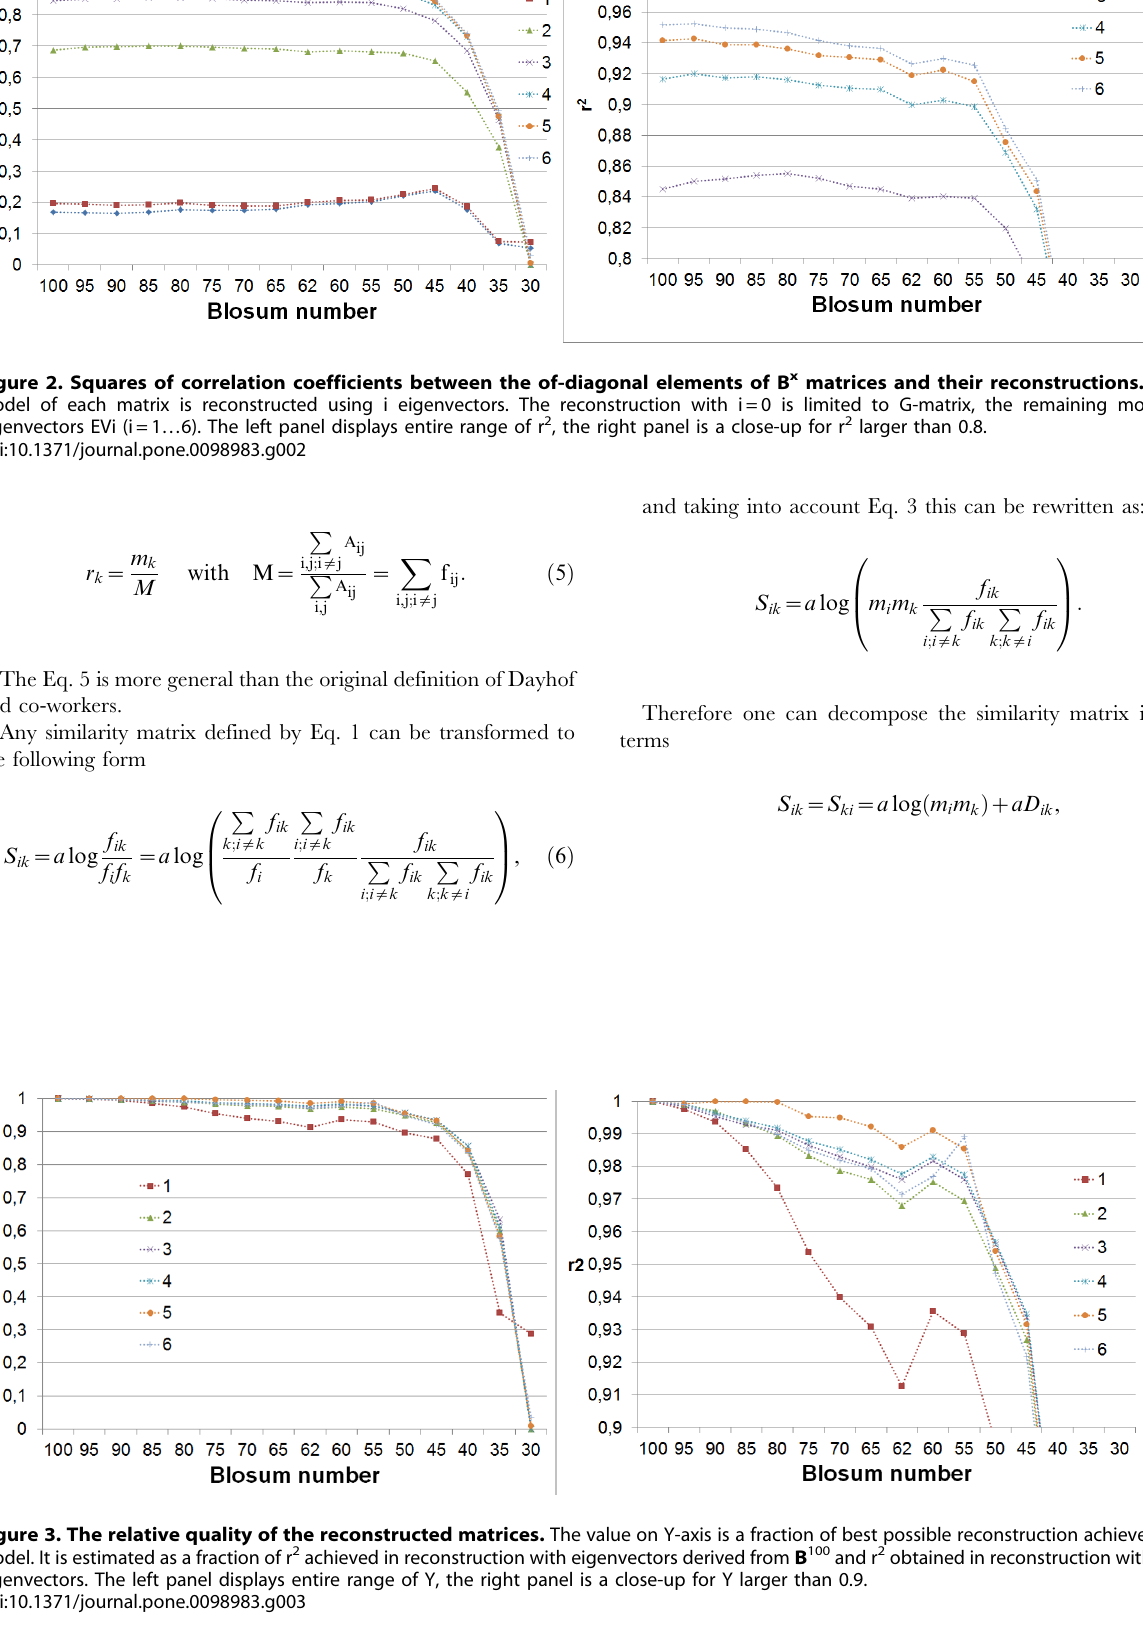
PLOS ONE | www.plosone.org 4 June 2014 | Volume 9 | Issue 6 |